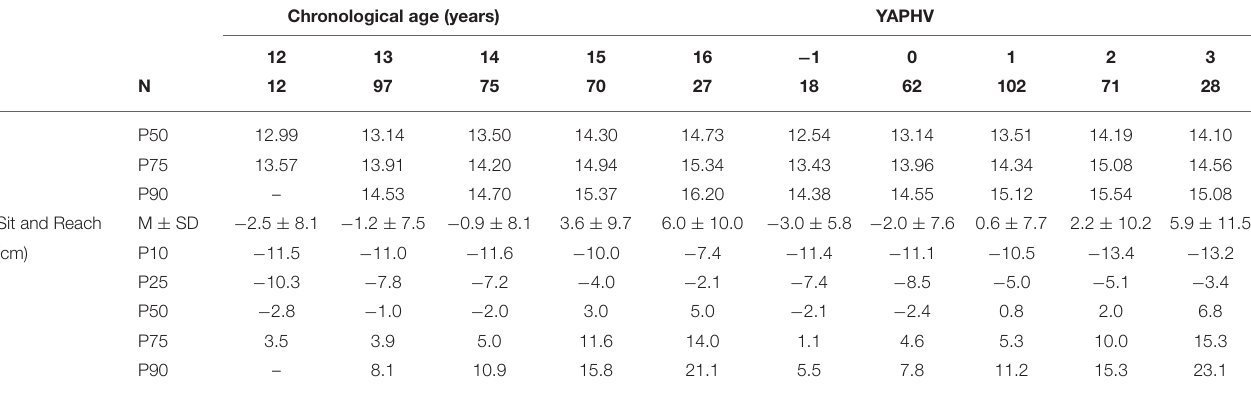
highlighted the relevance of maturity status for basketball players’ upper body strength and power (evaluated by the 2-kg MBT), where more mature players show higher upper body power than